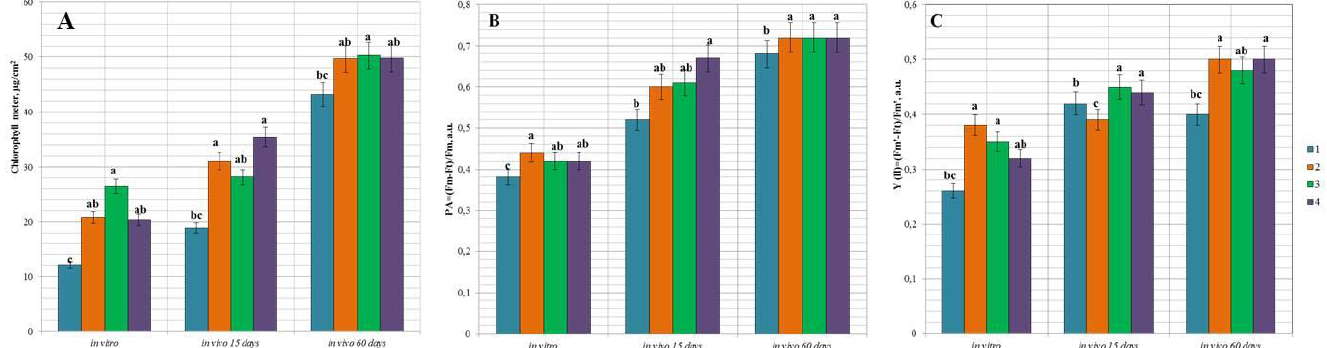
Figure 8. Parameters of the assimilation apparatus functioning in peach hybrids in vitro and under acclimatization in vivo: ( 1 ) ‘Clyde Wilson’ × ‘Nikitskiy Podarok’, ( 2 ) ‘Jerseyglo’ × ‘Nikitskiy Podarok’, ( 3 ) ‘Loadel’ × ‘Nikitskiy Podarok’, ( 4 ) ‘Summerglo’ × ‘Nikitskiy Podarok’. ( A ) chlorophyll meter, µ g/cm 2 , ( B ) photosynthetic activity, ( C ) effective photochemical quantum yield of PS II. Different lowercase letters in the same column indicated the significant difference at p ≤ 0.05 (Duncan’s multiple-range test).